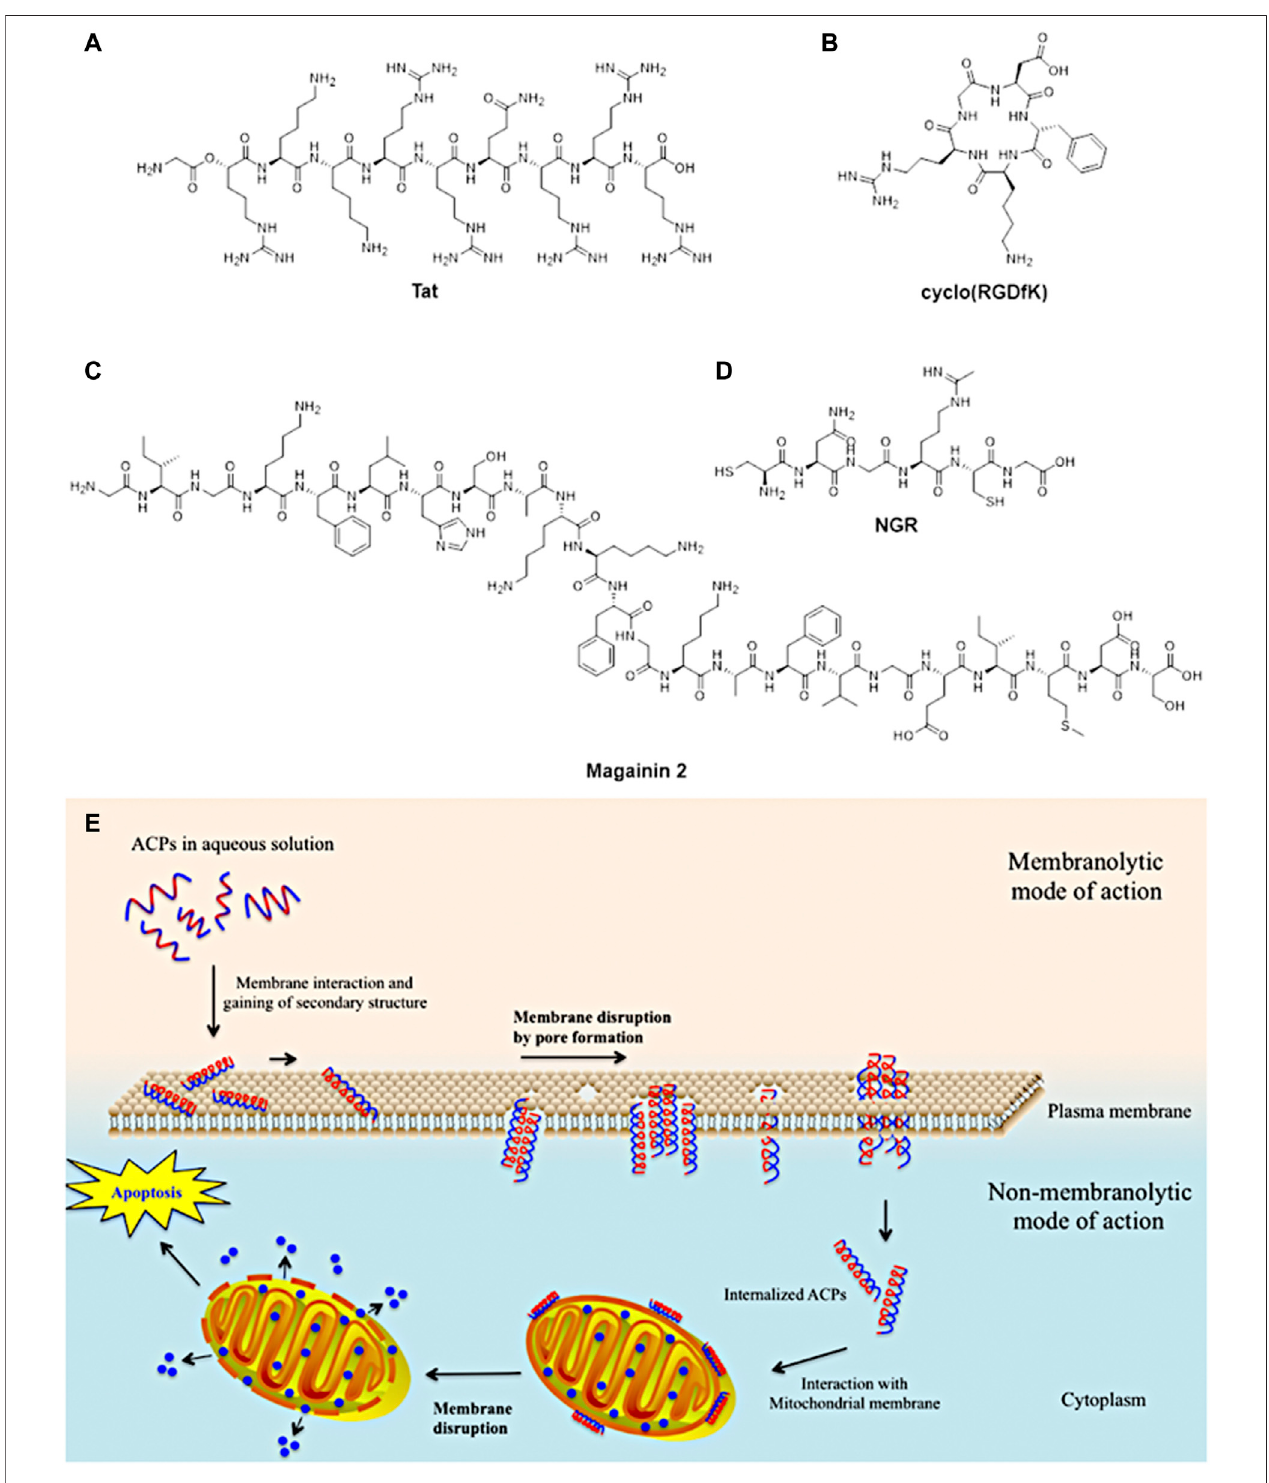
FIGURE 5 | Examples of small-sized peptides in pre-clinical and clinical trials of therapeutic agents. (A) Tat peptide for HIV therapeutic use; (B) cyclo (RGDfK) peptide for anticancer therapy such as breast, ovarian and prostate; (C) magainin 2 peptide for bladder anticancer agent and antimicrobial for diabetic ulcers; (D) NGR anticancer therapy such as ovarian, lung and colon ( fi gure adapted from Boohaker et al. (2012)). (E) Proposed mechanism of action of anticancer peptides into cancerous cells ( fi gure adapted from Tyagi et al. (2015).